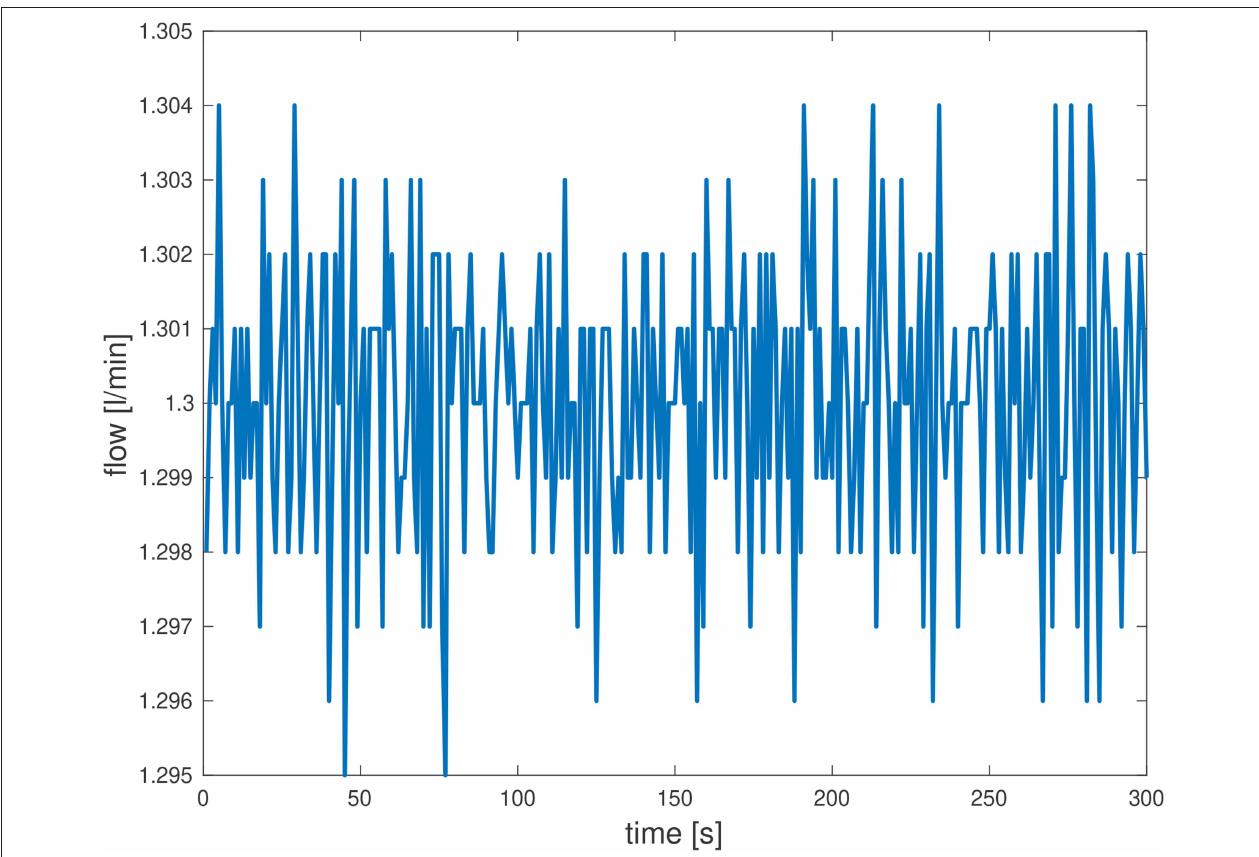
FIGURE 2 | Flow inside the ChemPro100i generated by the rotary vane pump, measured for grated lemon peel on a plate over 5 min. Measurement frequency was 1Hz.